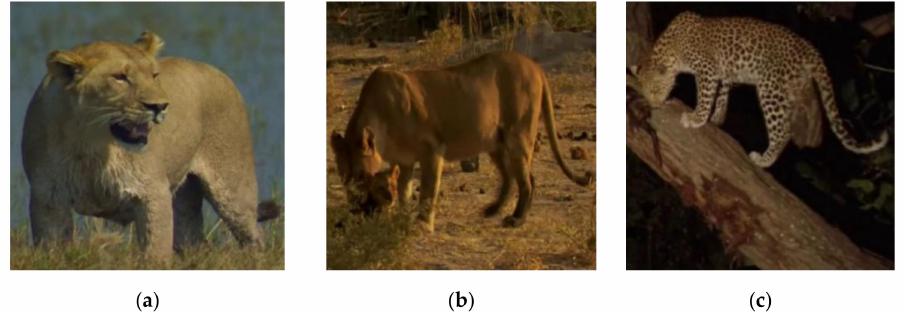
Figure 1. Examples of challenging images: ( a ) an image occluded by other objects, ( b ) an image camouflaged by the surroundings, and ( c ) an image taken at night.